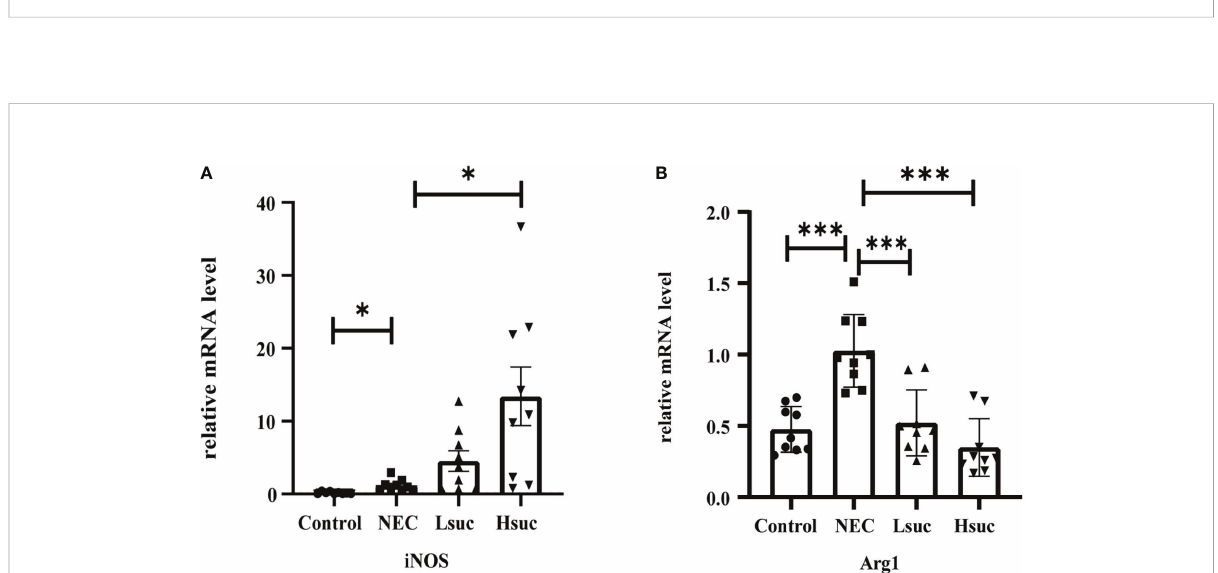
FIGURE 7 Relative mRNA expression of macrophage markers in the intestines of mice from four independent groups (n=9 per group). (A) iNOS, (B) Arg1. Dots indicate data from individual mice, and data are shown as the means ± SD. Statistical signi fi cance was assessed with one-way ANOVA followed by Dunnett ’ s post hoc test. * P < 0.05, *** P < 0.001.